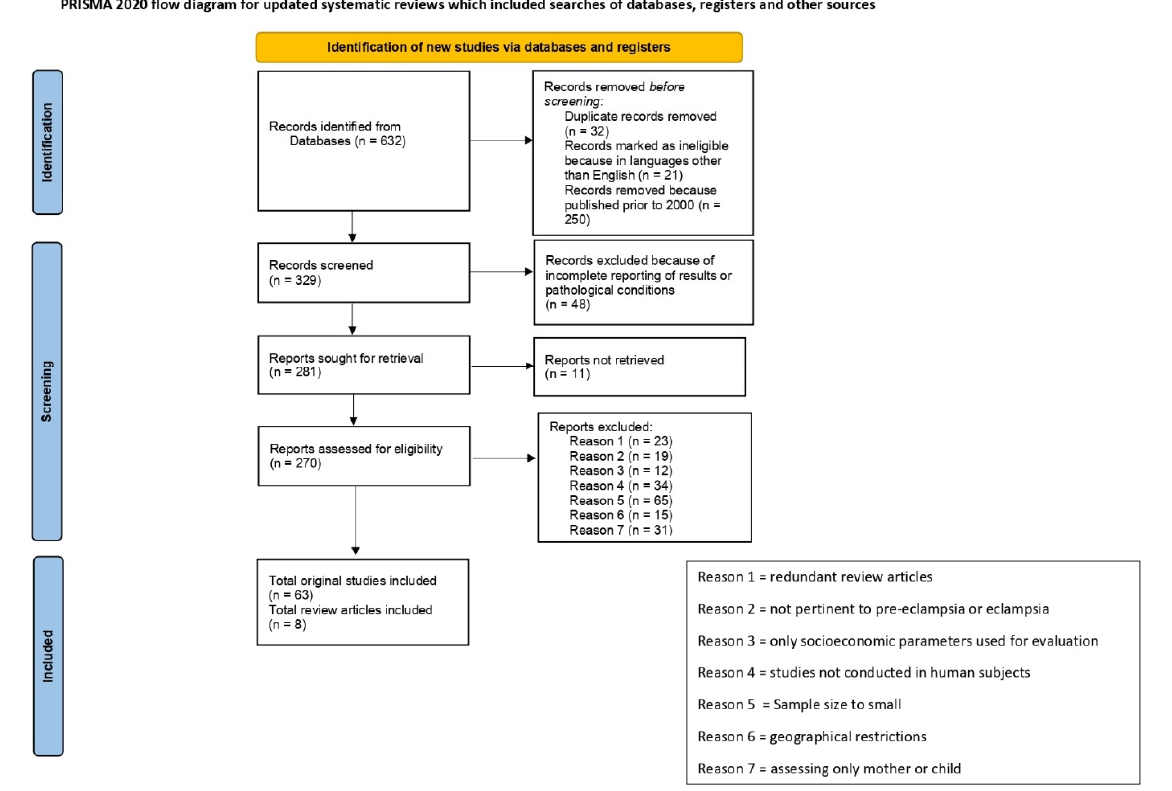
Figure 1. The flow chart illustrates the number of articles identified through the literature search and the inclusion/exclusion screening criteria to select the pertinent articles to be included in the review.